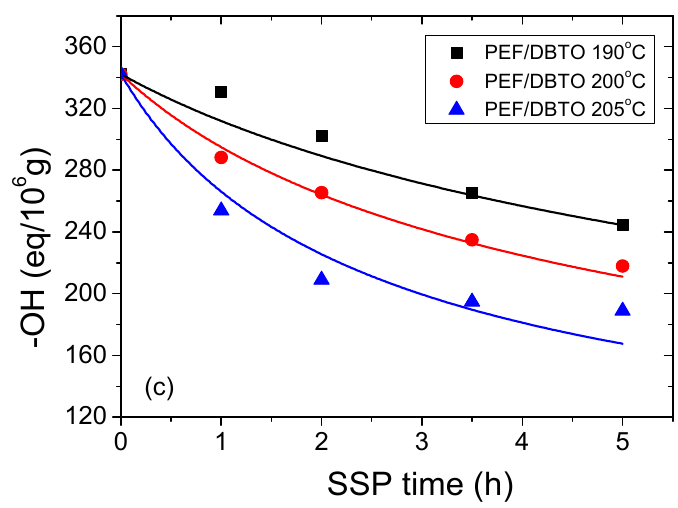
Figure 4. Variation of hydroxyl end groups with time during PEF/TIS ( a ), PEF/TBT ( b ), and PEF/DBTO ( c ) SSP at different temperatures. Continuous lines represent the theoretical kinetic model simulation results.